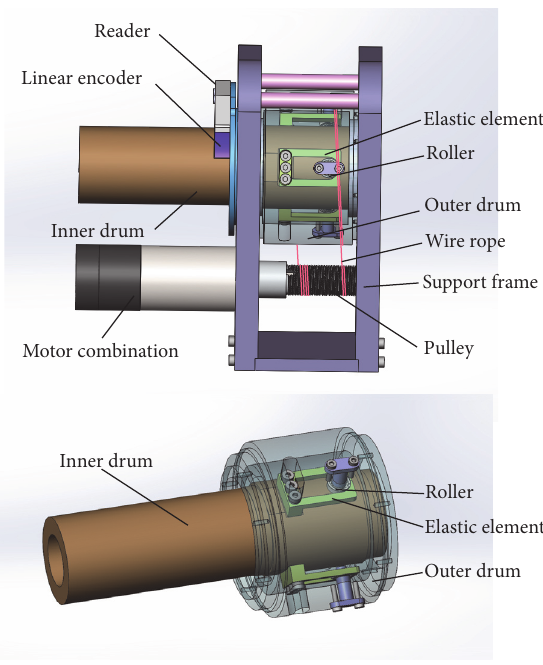
Figure 1: CAD model of the first joint of rehabilitation